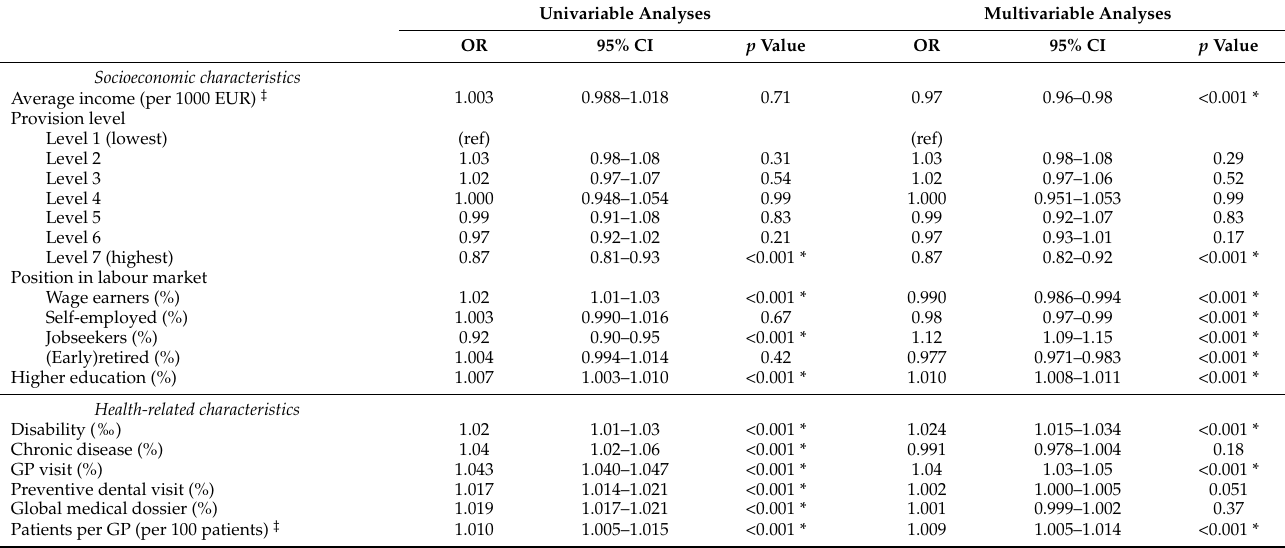
Table 3. Cont. Univariable Analyses